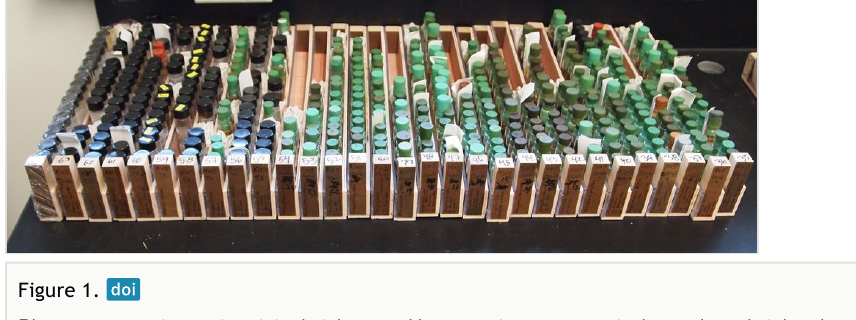
Plecoptera specimens in original vials sorted by taxon into consecutively numbered vial racks.